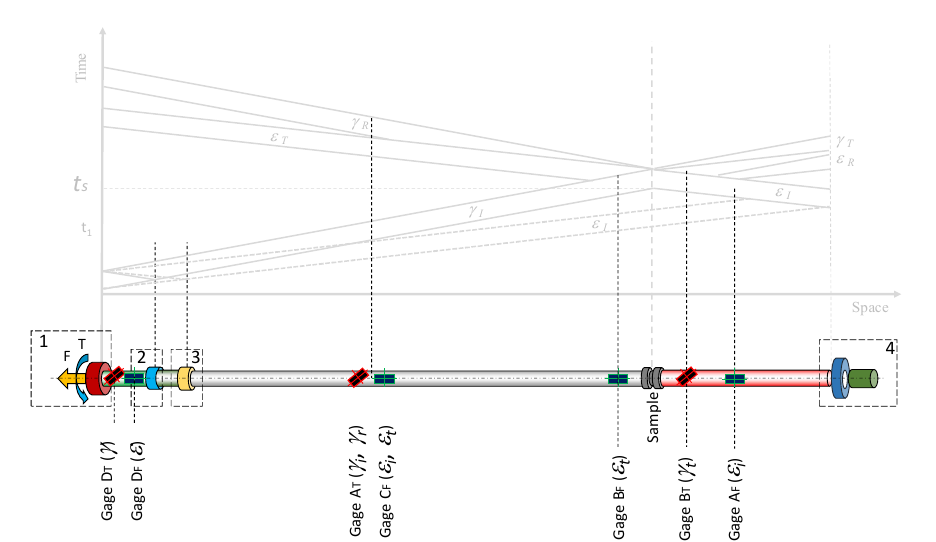
Fig. 4. Lagrangian diagram of the whole